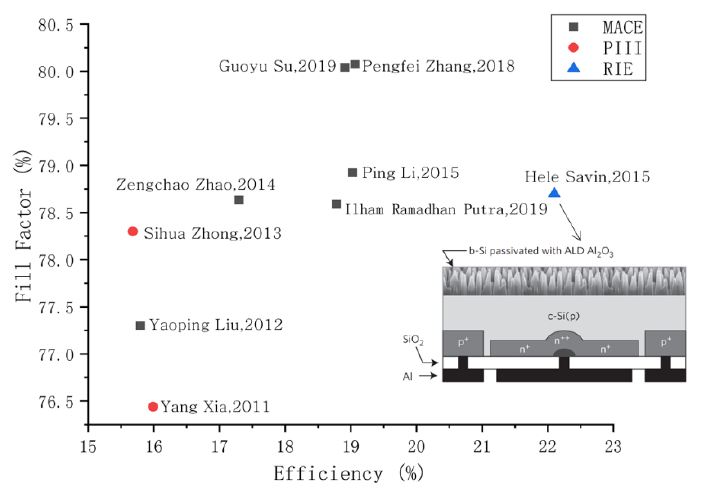
Figure 11. Performances comparison of solar cells based on black silicon, the inset shows black silicon solar cells with interdigitated back-contacts.